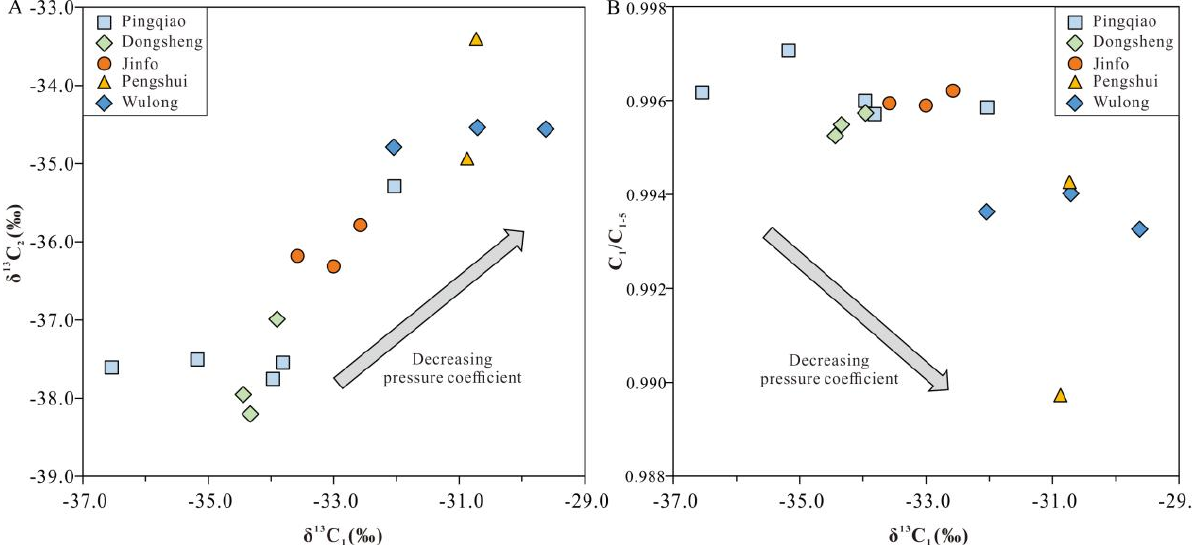
Figure 4. Plots of ( A ) δ 13 C 1 vs. δ 13 C 2 and ( B ) δ 13 C 1 vs. C 1 /C 1-5